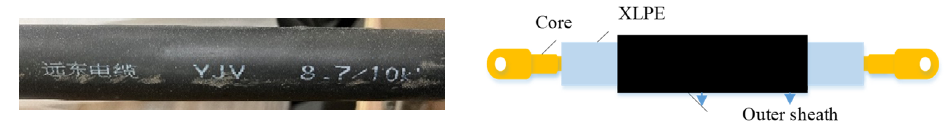
Figure 1. Sample pretreatment diagram.